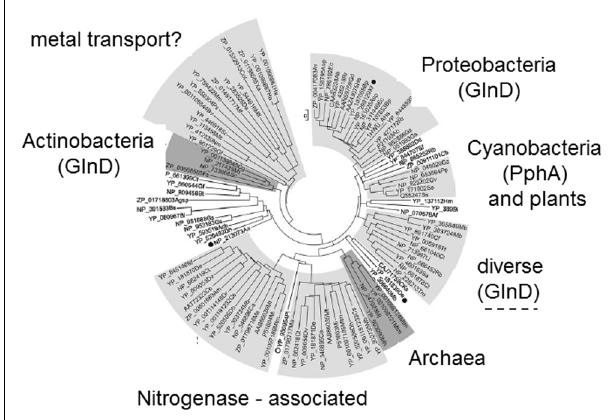
FIGURE 2 | Phylogenetic tree of P II proteins showing those groups in whichT-loop modification occurs . Phylogenetic analysis of the P II protein family (Sant’Anna etal., 2009) identified at least seven distinct groups four of which are associated with specific taxonomic groups of organisms.Two groups appear to be associated with specific processes in taxonomically diverse organisms: one group control nitrogenase in certain diazotrophs (Leigh and Dodsworth, 2007) and the other group is often genetically linked to metal transport genes. Post-translational modification has only been described in four groups within the tree. Uridylylation (mediated by GlnD) is found in the proteobacteria and some “diverse” bacteria. Adenylylation (also mediated by GlnD) is found in the actinobacteria. Phosphorylation (associated with the presence of the phosphatase PphA) is found in some cyanobacteria but not in